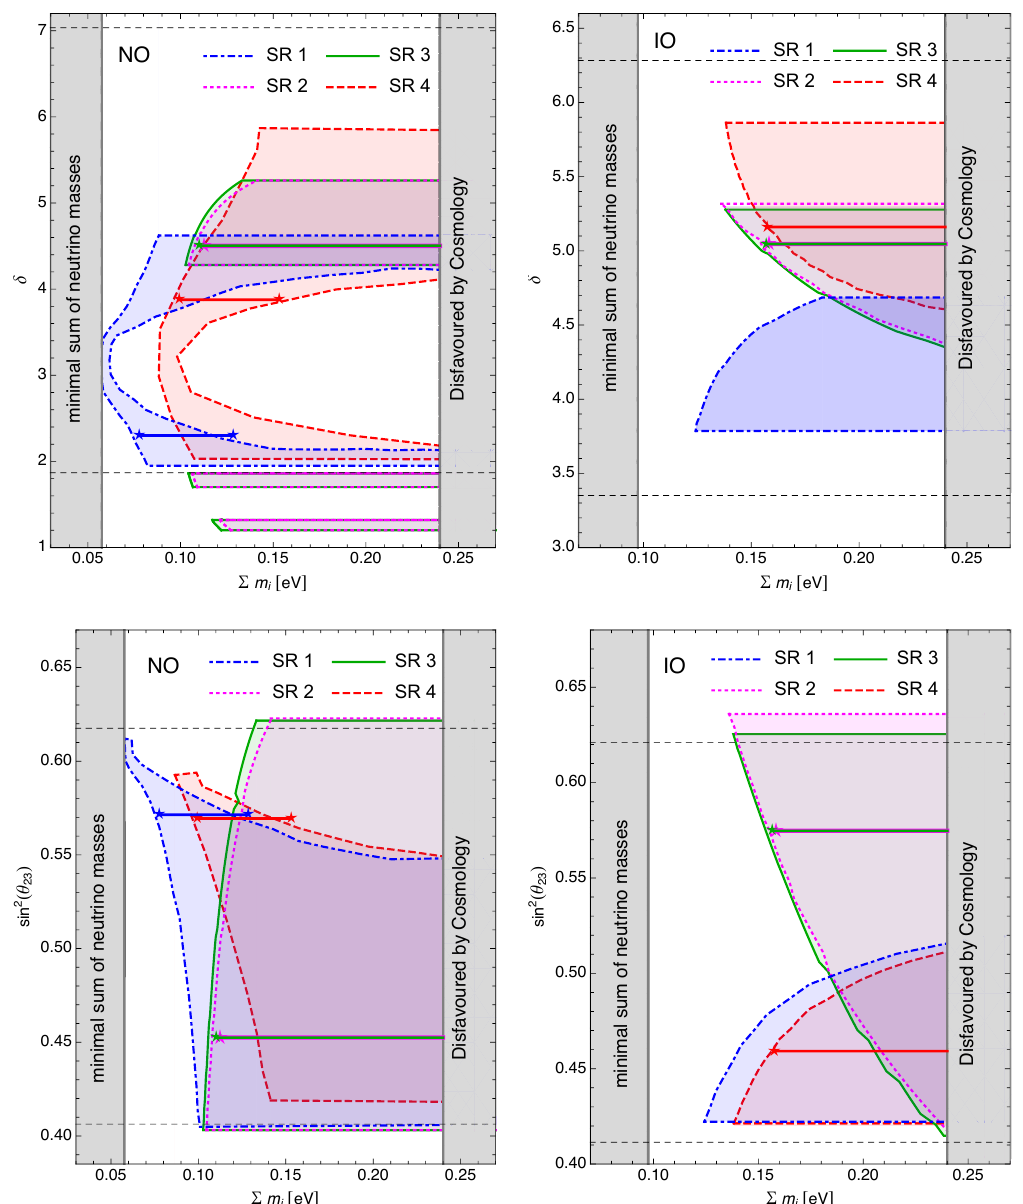
Figure 6 . Allowed ranges for the mixing parameters depending on the sum of the neutrino masses for all SR in NO (left panels) and IO (right panels) for θ, φ and the mass splittings in their 3 σ ranges. The stars and thick lines show the best fit regions in these models. Notice that for SR 1, IO the mass sum rule cannot be fulfilled if θ, φ are at best fit. The black dashed lines show the 3 σ allowed region without sum rules for NO/IO. The gray exclusion regions show the minimal value of the sum of the neutrino masses from oscillation experiments and the maximal value of the sum of the neutrino masses from